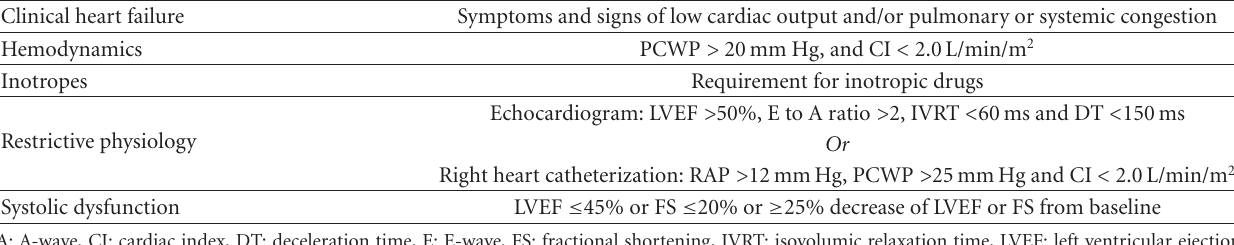
Table 1: Definition of allograft dysfunction ( ≥ 1 criteria